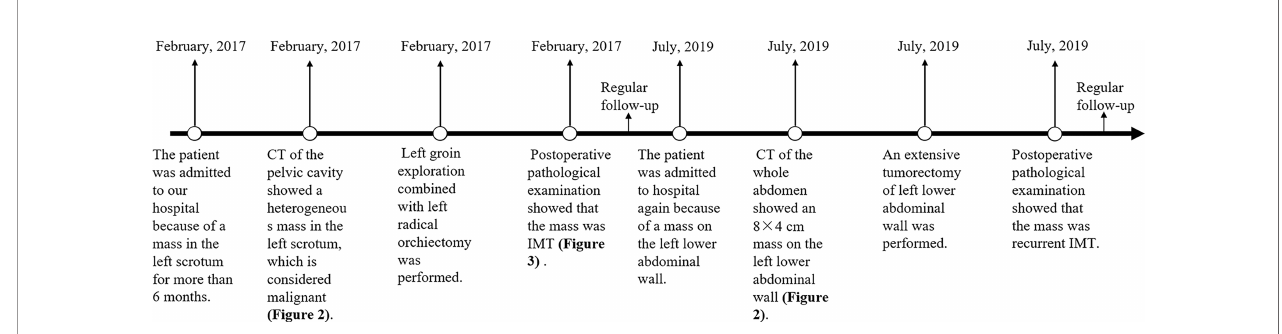
FIGURE 1 | Time axis. Time axis of treatment of primary and recurrent tumours.